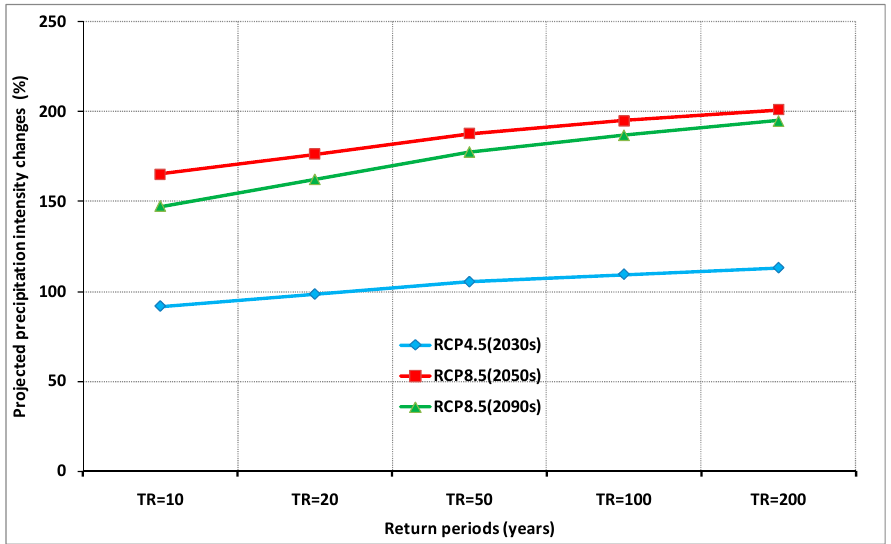
Figure 9. Median of projected precipitation intensity changes for durations from 1 to 72 h with different return periods (TR) under scenarios of RCP4.5 (2030s), RCP8.5 (2050s) and RCP8.5 (2090s).